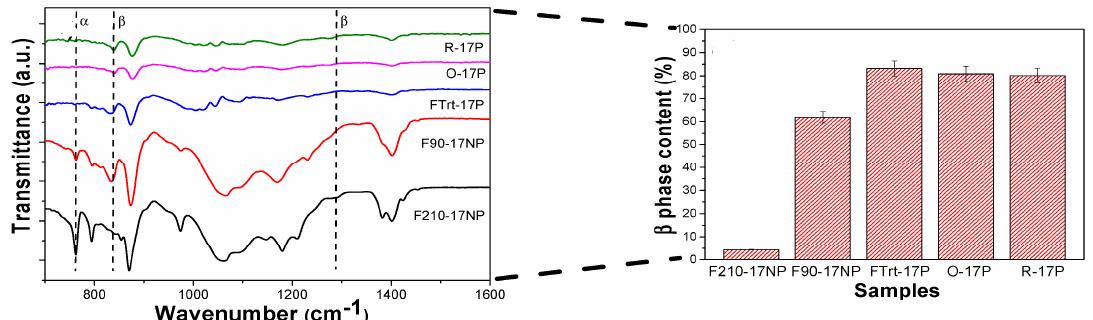
Figure 6. FTIR spectra of nonporous PVDF/silica (17 nm) nanocomposite films processed at 90 °C (F90-17NP) and at 210 °C (F210-17NP), porous nanocomposite film processed at room temperature (FTrt-17P), electrospun nanocomposite mats with oriented (O-17P) and random (R-17P) fibers. Right panel displays the β -phase content of these nanocomposites.